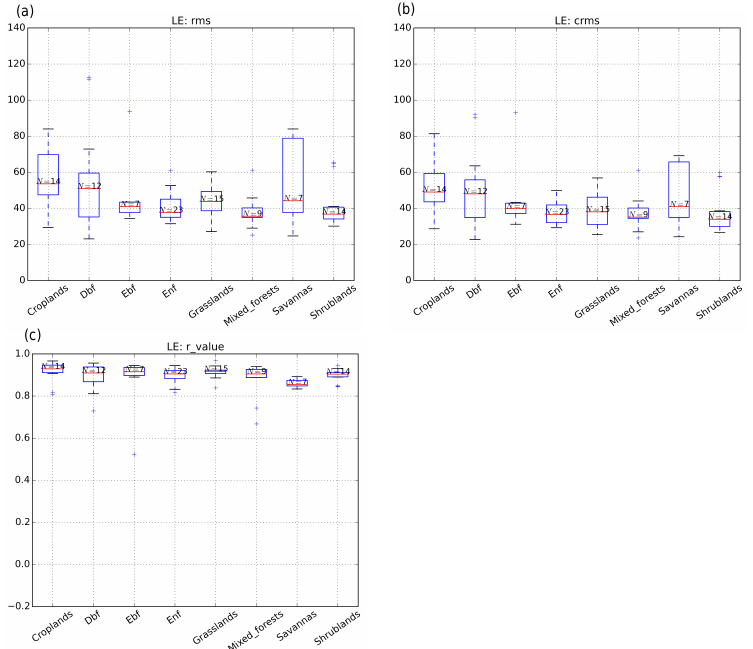
Figure E2. Error statistic for hourly latent heat flux over different biomes: (a) RMSD, (b) cRMSD, (c) correlation coefficient. Dbf is deciduous broadleaf forest, Ebf is evergreen broadleaf forest, Enf is evergreen needleleaf forest.